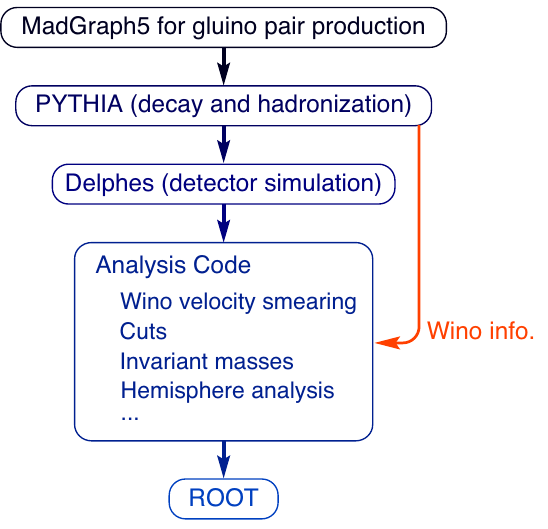
Figure 1 . The (cid:13)owchart of our MC